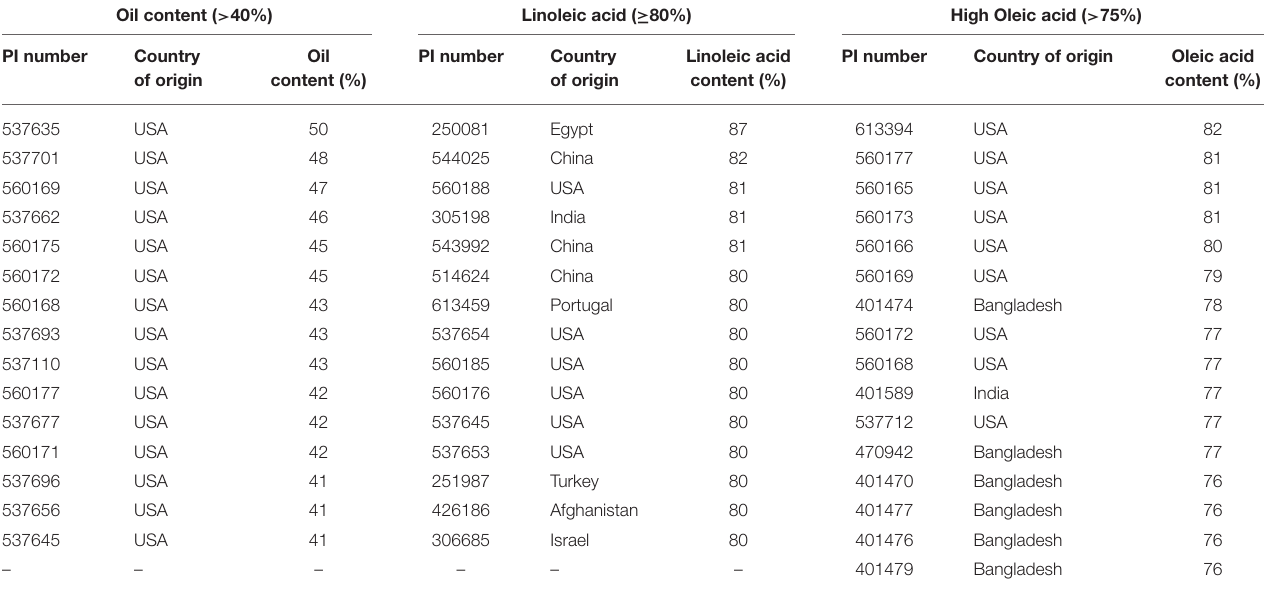
TABLE 1 | List of safflower accessions with high oil content ( > 40%), linoleic acid content ( ≥ 80%), and oleic acid content ( > 75%). Oil content ( >